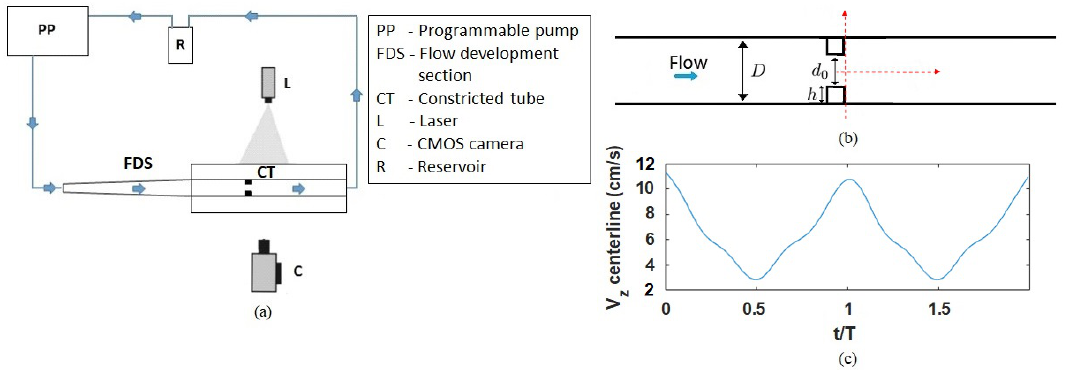
Figure 1: : (a) Schematic drawing of the experimental setup; (b) lengthwise view of a tube of diameter D = 2 . 6 ± 0 . 1 cm and an annular constriction of diameter d 0 ; (c) experimental axial velocity at z = 0 and r = 0 for ¯ Re = 1106, with d 0 = 1.6 cm